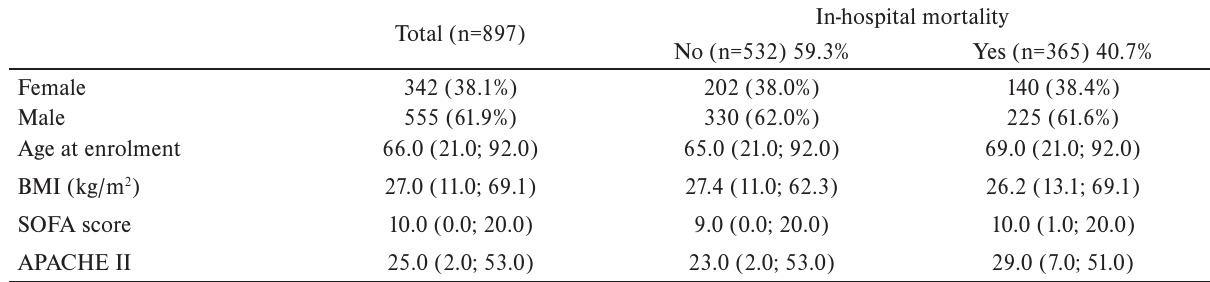
Table 3. Basic description at enrolment – gender, age, BMI, SOFA and APACHE II.